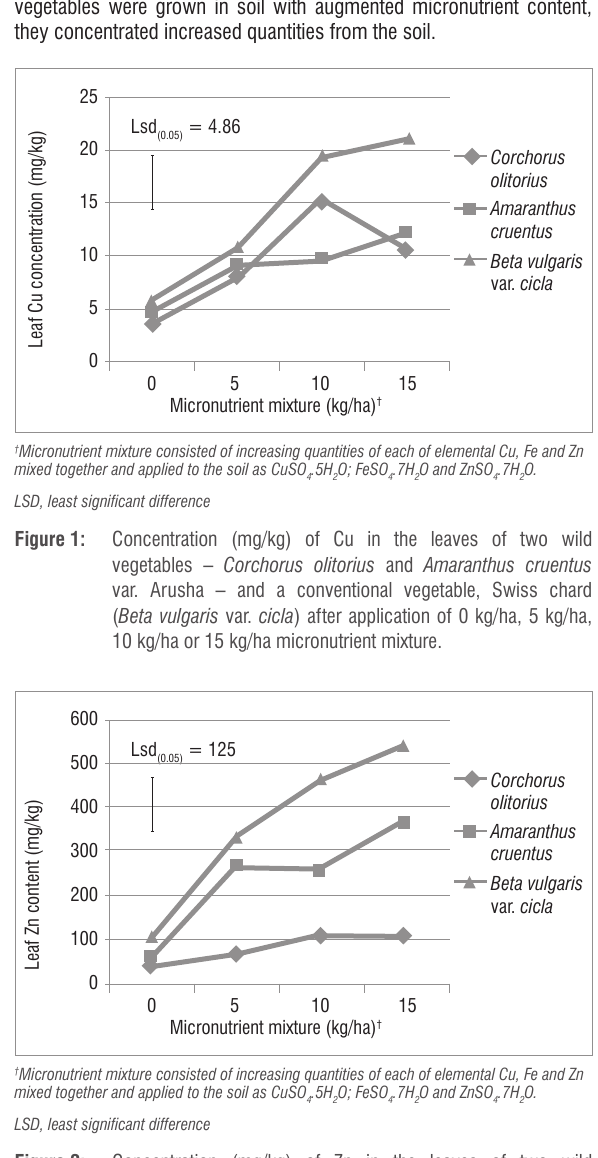
Figure 2: Concentration (mg/kg) of Zn in the leaves of two wild vegetables – Corchorus olitorius and Amaranthus cruentus var. Arusha – and a conventional vegetable, Swiss chard ( Beta vulgaris var. cicla ) after application of 0 kg/ha, 5 kg/ha, 10 kg/ha or 15 kg/ha micronutrient